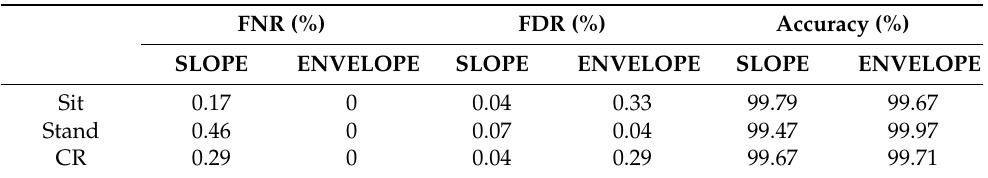
Table 2. FNR, FDR, and accuracy observed with each method, grouped by protocol phases. Assess- ment performed with PPG signals sampled at 64